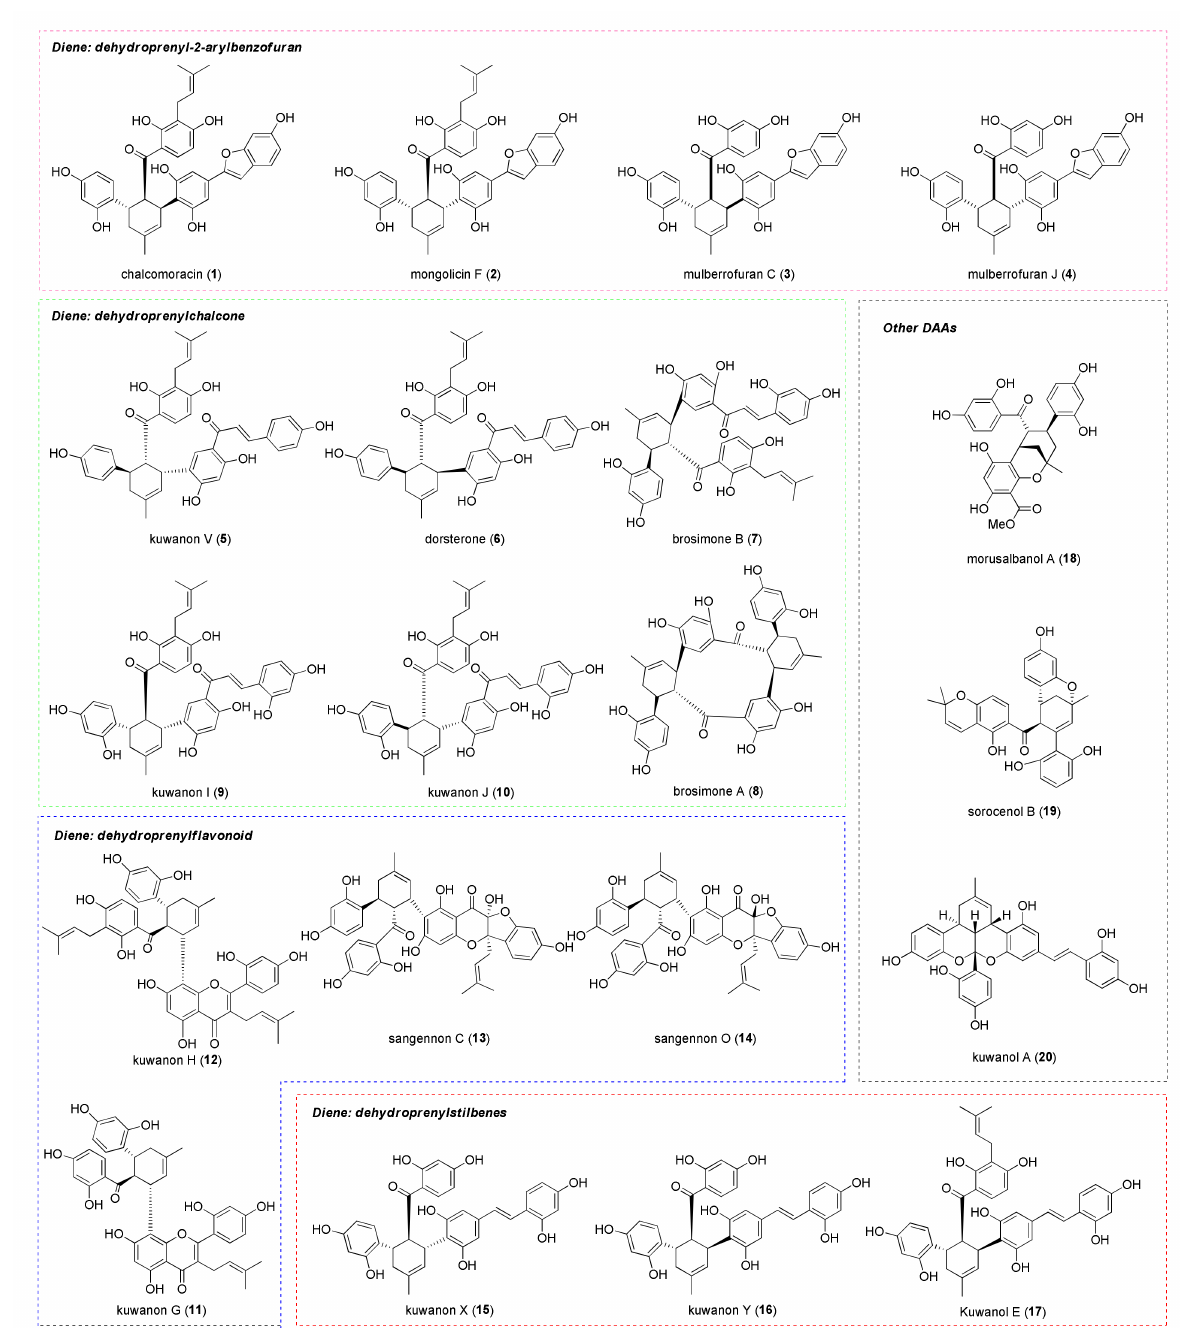
Figure 1. Diels–Alder adducts from the Moraceae family, whose synthetic approaches will be discussed in this